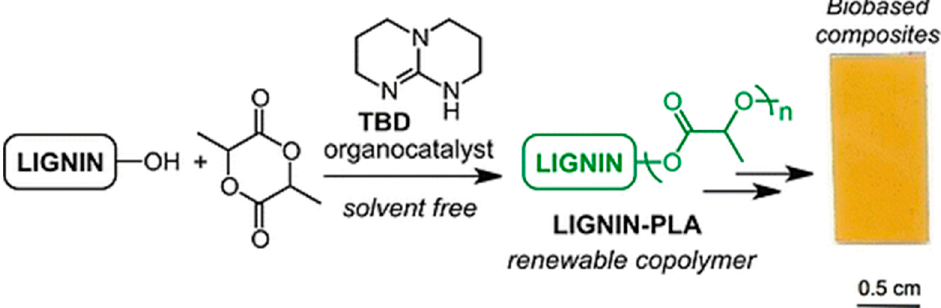
Figure 27. Ring-opening polymerization of lactide on lignin using triazabicyclodecene (TBD) organocatalyst. Reproduced with permission [93].